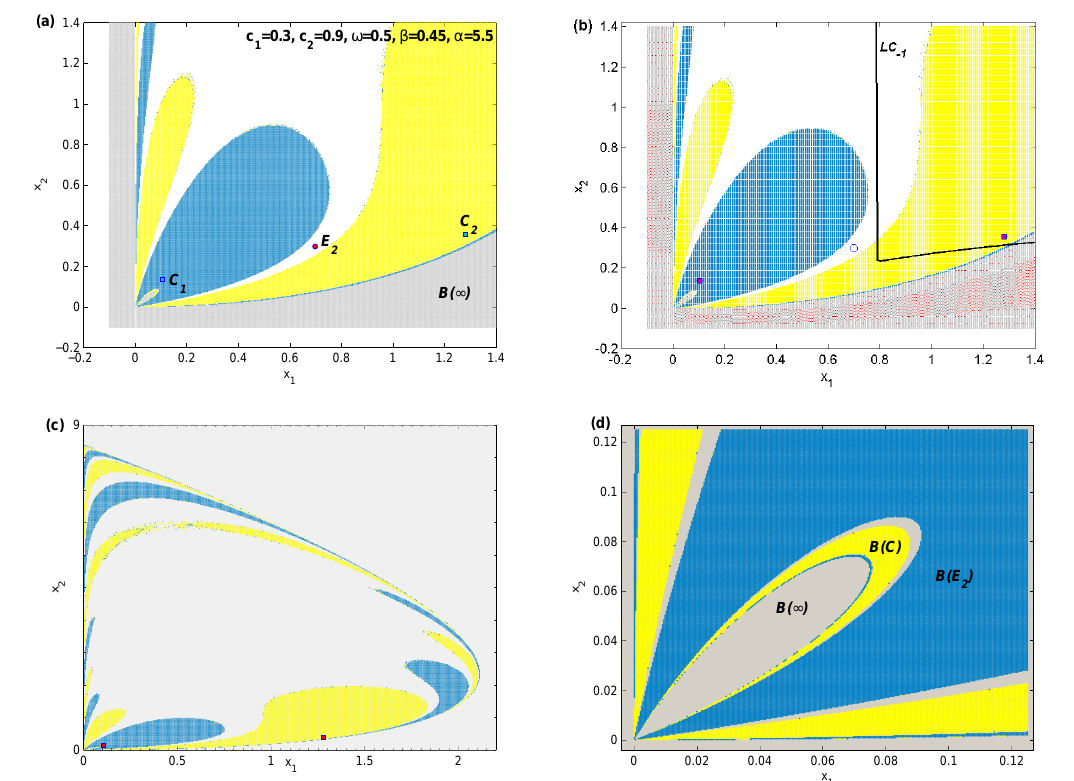
Figure 5. ( a – d ) Phase plane at the parameters’ values, c 1 = 0.3, c 2 = 0.9, ω = 0.5, β = 0.45 and α = 5.5. The grey color indicates divergent and unfeasible trajectories. The white color indicates non-convergent trajectories. The other two colors indicate the basins of attraction of the period 2-cycle appearing with the equilibrium point E 2